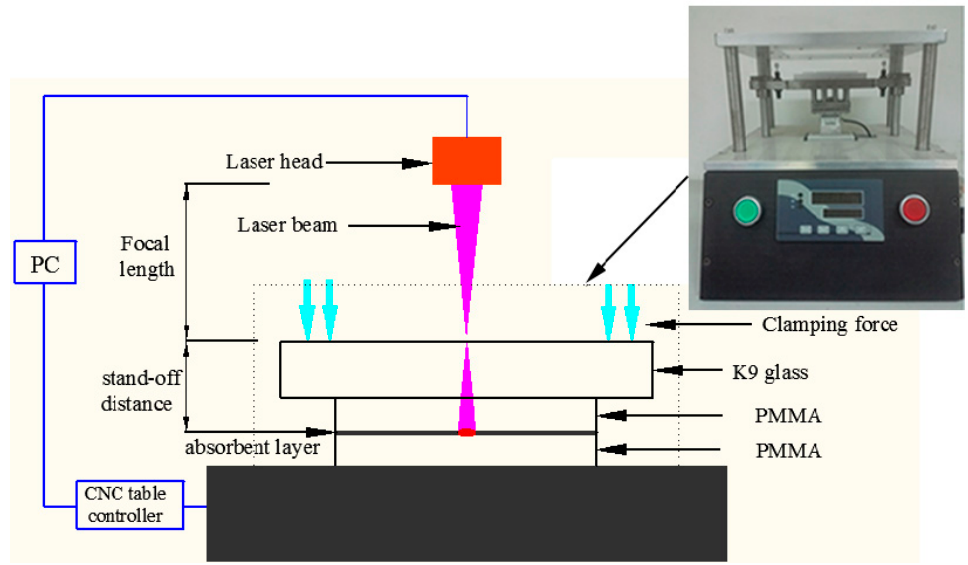
Figure 1. Schematic diagram of a laser transmission spot welding experiment device.